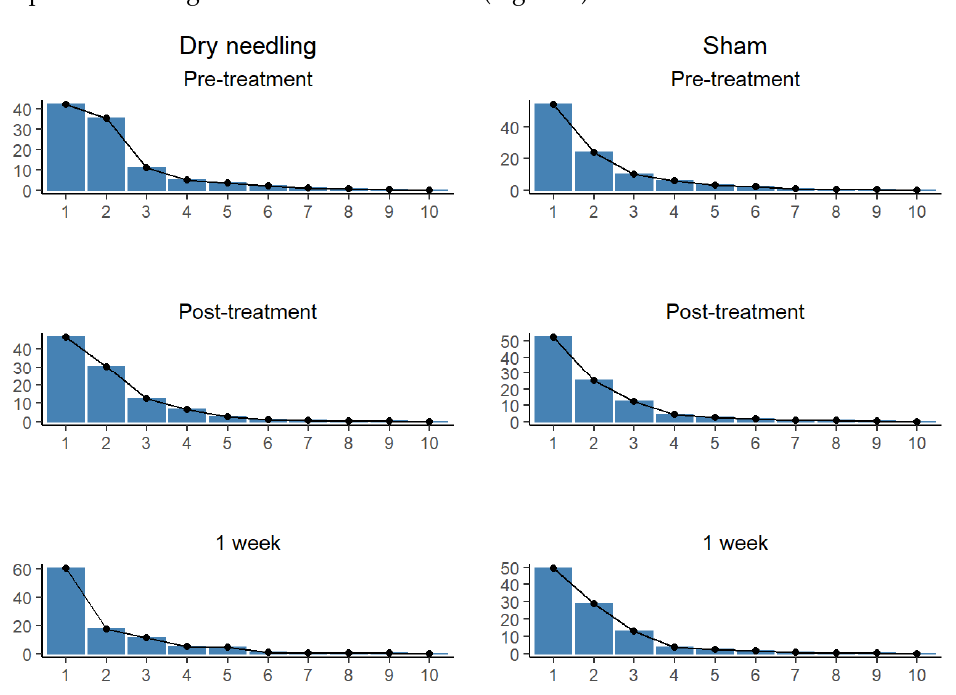
Figure 2. Variance explained by each principal component .